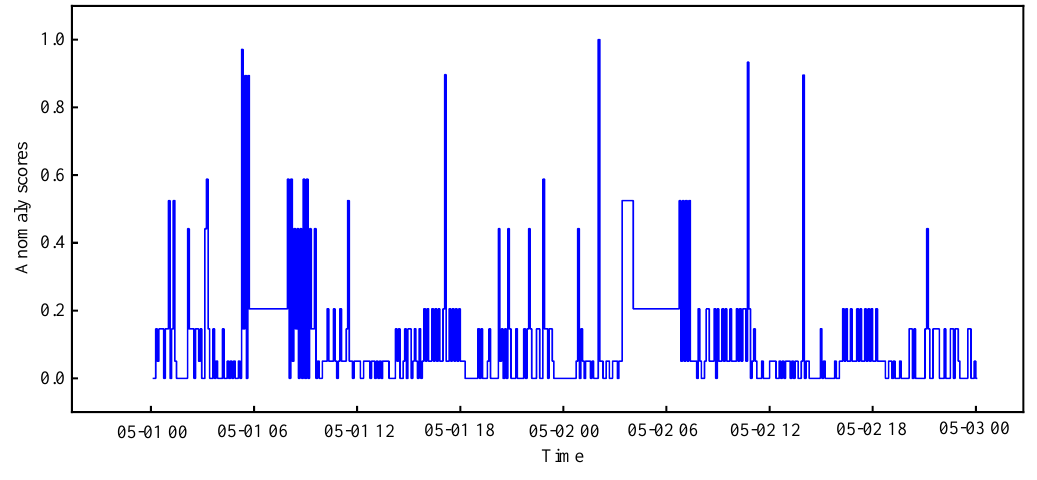
Figure 2. Anomaly scores of data.